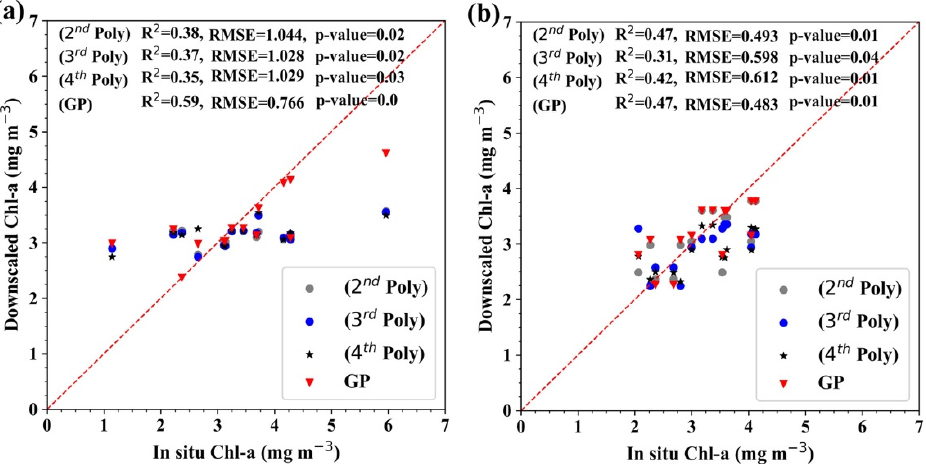
Figure 9. 1:1 scatter plots of downscaled MODIS Chl-a and in situ data for all methods using two measured data at 0–15 cm depth; ( a ) the winter day (2016.2.2) and ( b ) the summer day (2016.8.4).